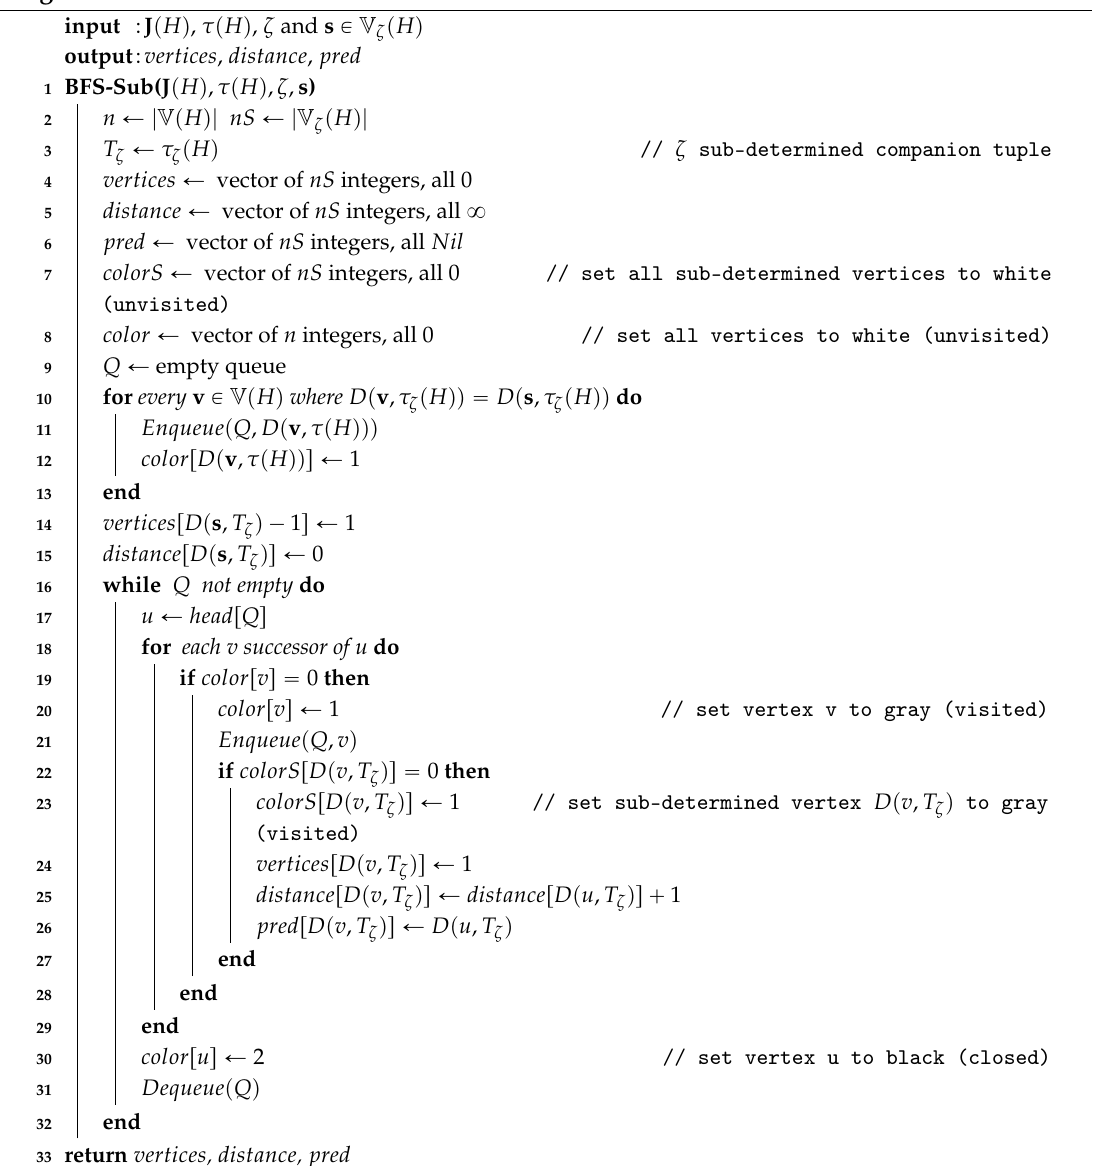
Algorithm 12: Sub-determined